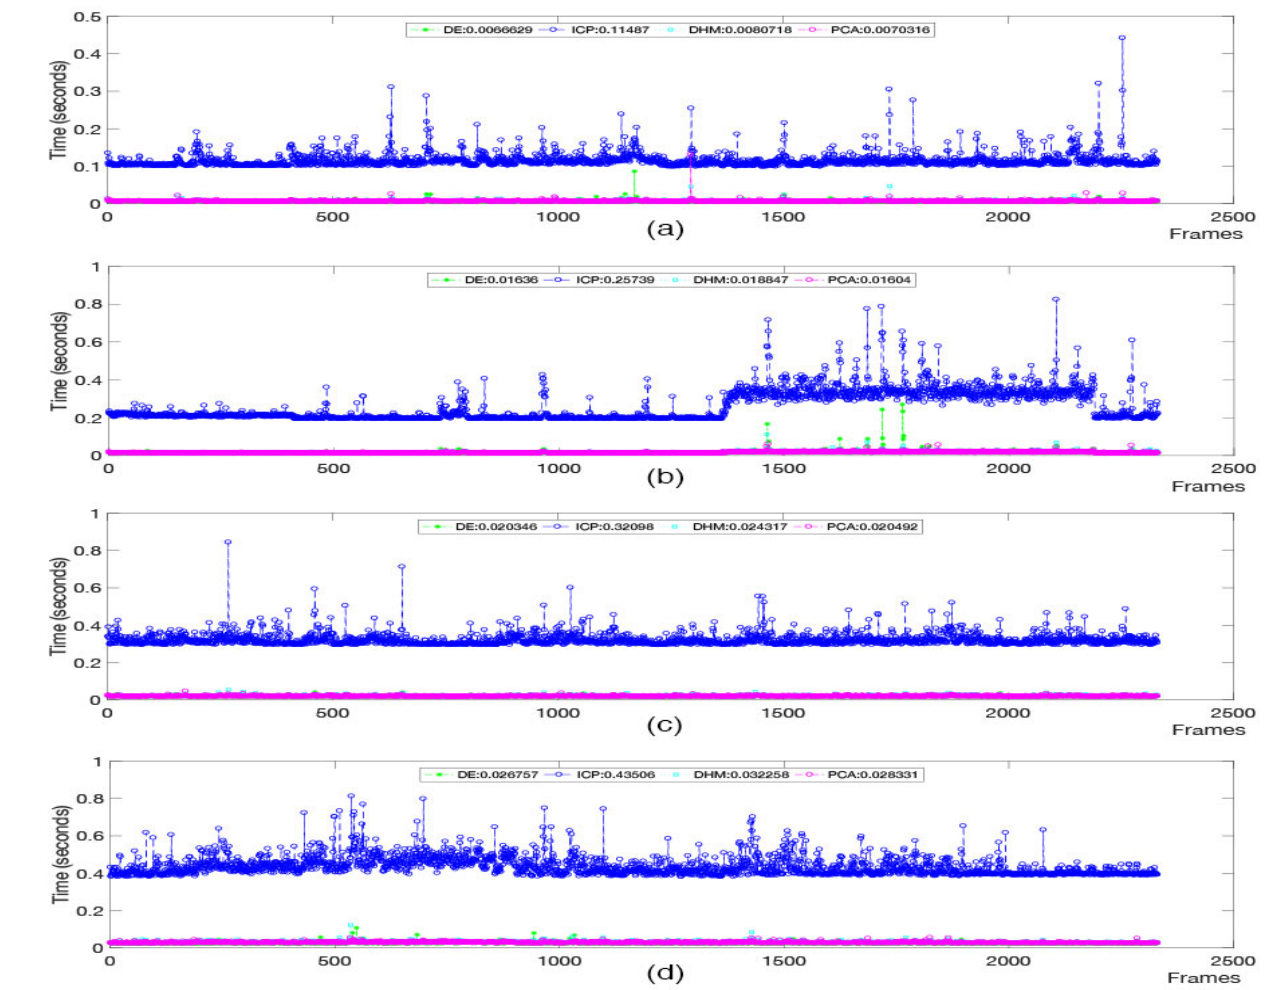
Fig. 12. Graphs showing the time spent per algorithm, frame by frame, for the amount of selected blendshapes. (a) 25 percent (21 blendshapes); (b) 50 percent (41 blendshapes); (c) 75 percent (62 blendshapes) and (d) 100 percent (81 blendshapes).